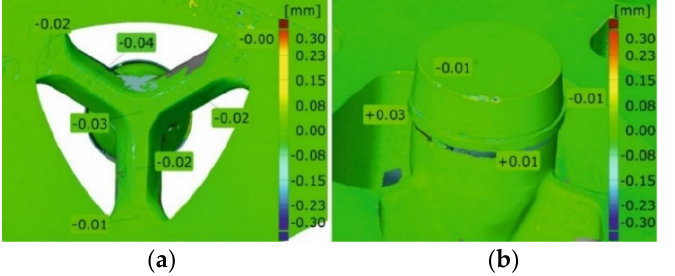
Figure 25. Results of optical scanning of the porthole dies for extrusion of tubes of Ø50 × 2 mm from 6082 alloy: die deflection—close-up of the bridge view ( a ) and the mandrel view ( b ).